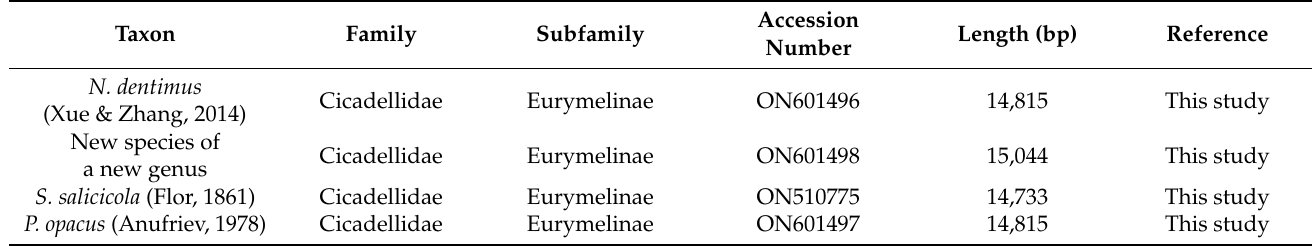
Table 2. Taxon information and the GenBank accession numbers of 20